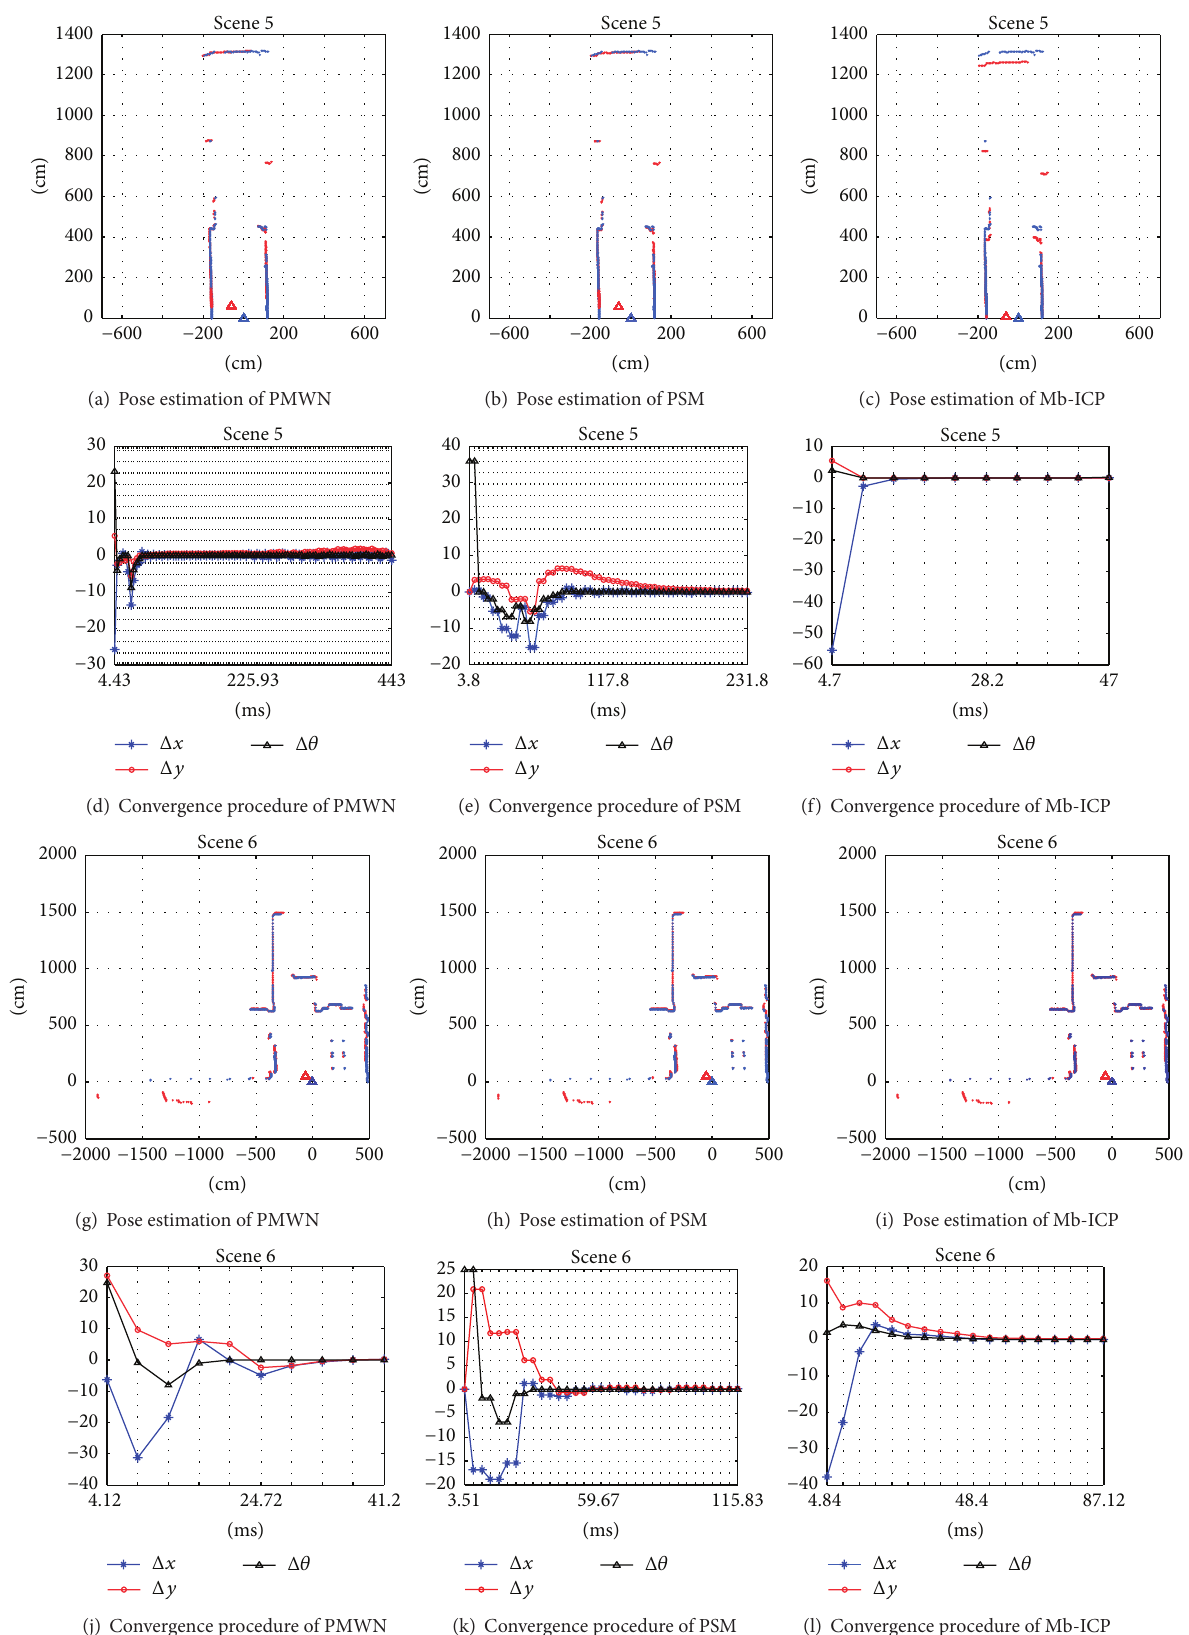
Figure 12: Scenes in Environment